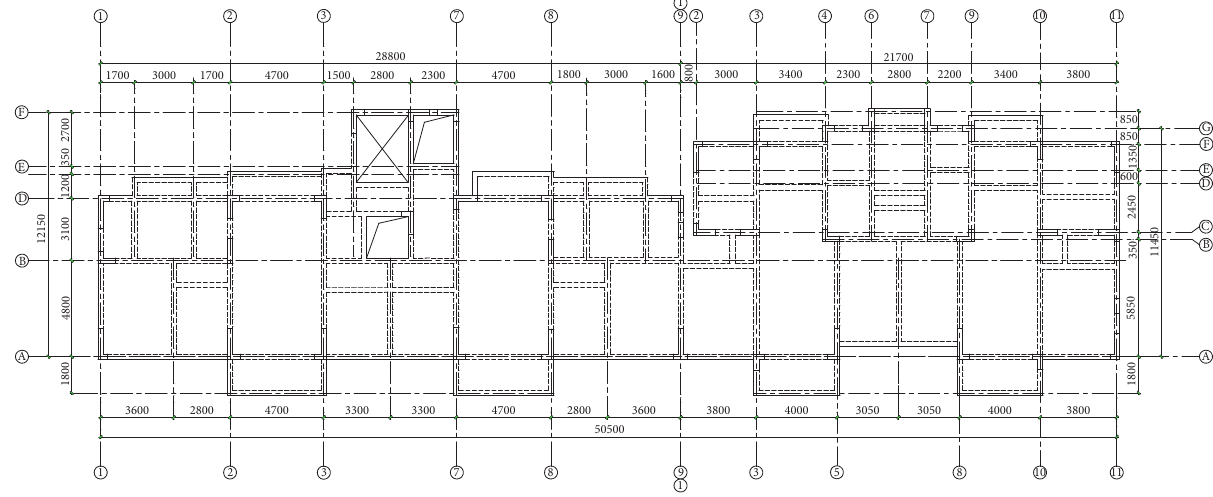
Figure 13: Arrangement in the structures.